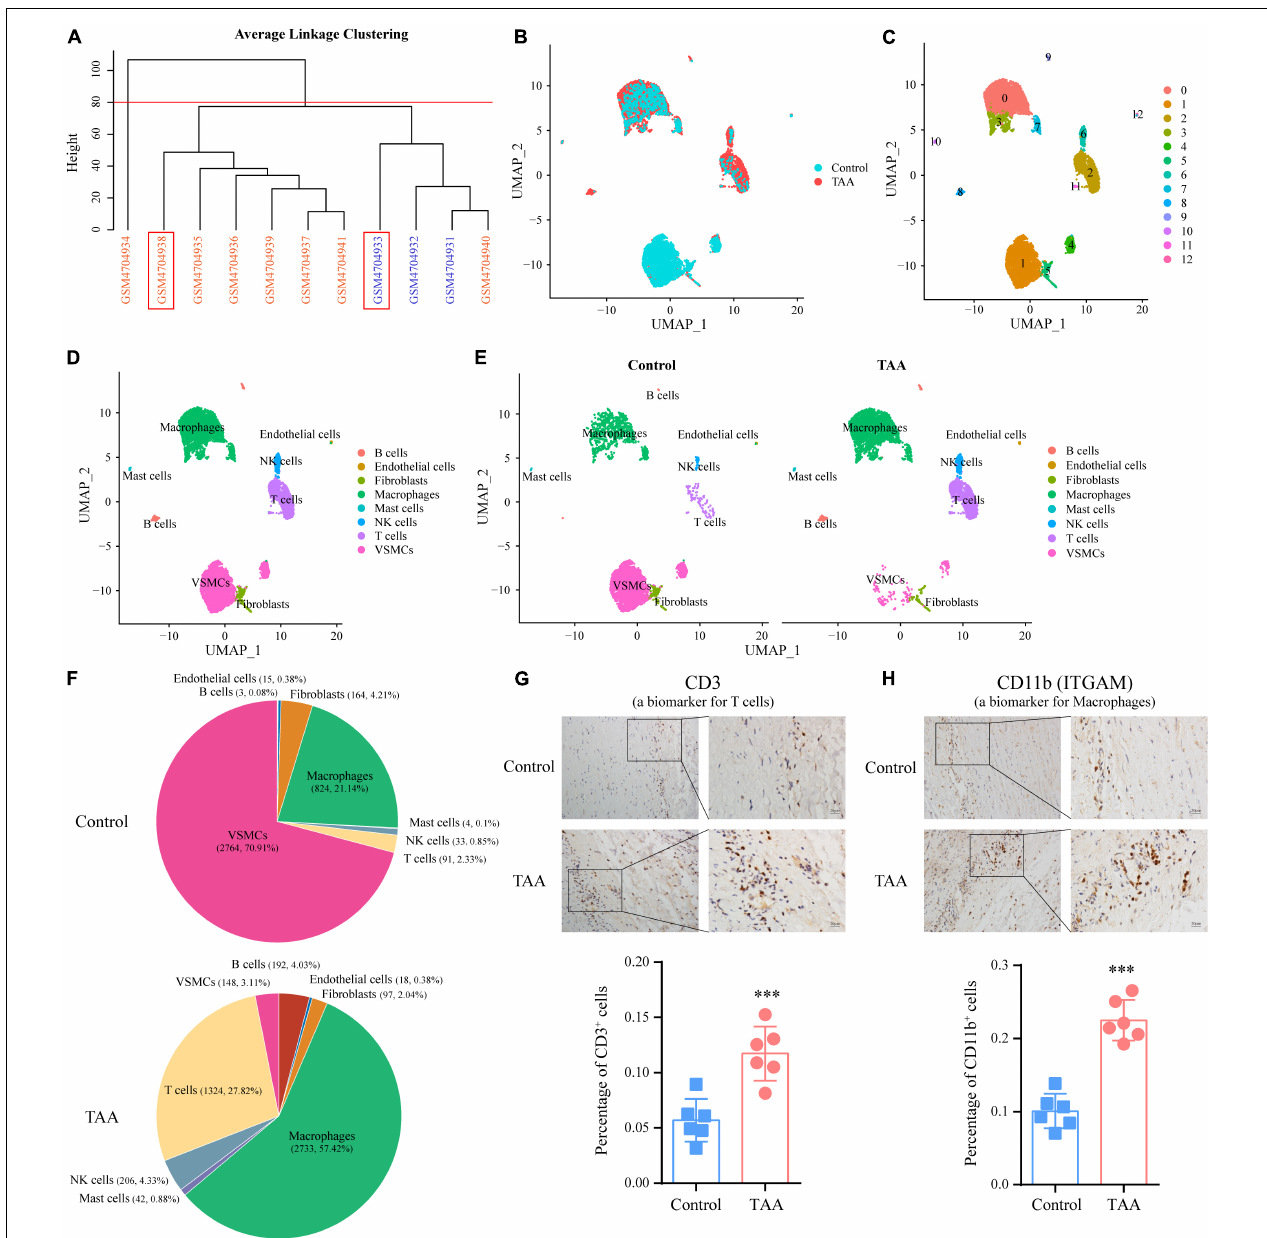
FIGURE 3 | Identification of cell populations by single-cell RNA sequencing (scRNA-seq) analysis in TAA and control samples. (A) Sample clustering was performed based on the cellular composition of the 11 samples (8 TAA samples and three controls). Among them, GSM4704938 (TAA sample) and GSM4704933 (control sample) were chosen for further analysis. (B) Cell distributions in TAA and normal aortic samples are shown in a uniform manifold approximation and projection (UMAP) plot. After quality control, 4,760 and 3,898 cells from TAA and normal aortic samples, respectively, were captured for clustering analysis. (C) UMAP plot displaying the aggregate cells with colors denoting different clusters. (D) UMAP plot showing the identification of cell types for cell clusters based on cell-specific markers. (E) A comparison of the identified cell populations between the TAA and control groups is shown in the UMAP plot. (F) Pie plot exhibiting the percentages of each cell population in the control and TAA groups. (G,H) IHC staining showing the expression levels of CD3 (a marker of T cell; G ) and CD11b (a marker of macrophage; H ) in human TAA and normal aortic samples, which validated the elevation of the T cells and macrophages in TAA. ∗∗∗ p < 0.001; n = 6, Student’s t